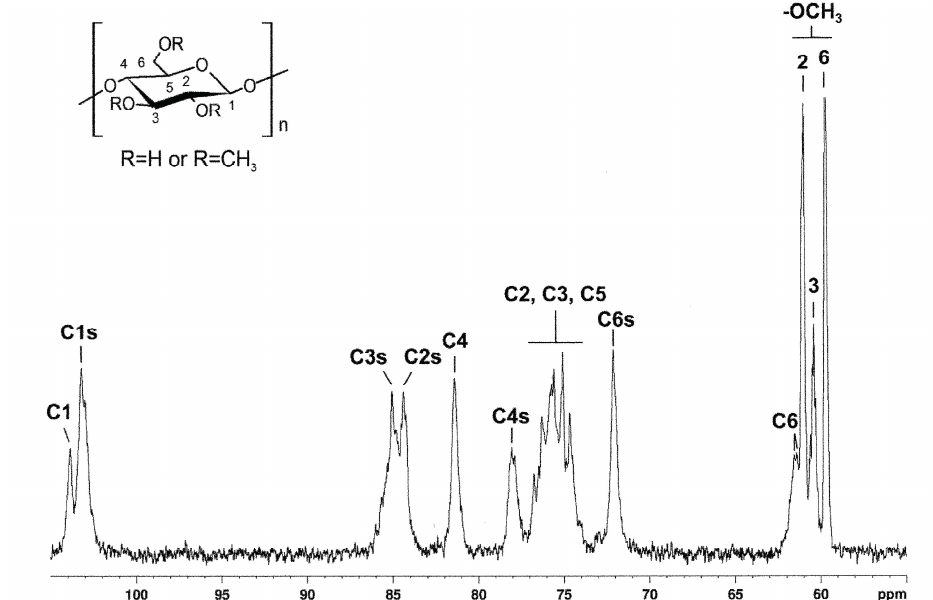
Figure 2. 13 C-NMR spectrum of methylcellulose A4C (30 g/L in DMSO-d 6 at 80 °C). C x and C x s correspond to the signals of carbon x unsubstituted and substituted, respectively. Reproduced with permission from Taylor & Francis Group, 2015